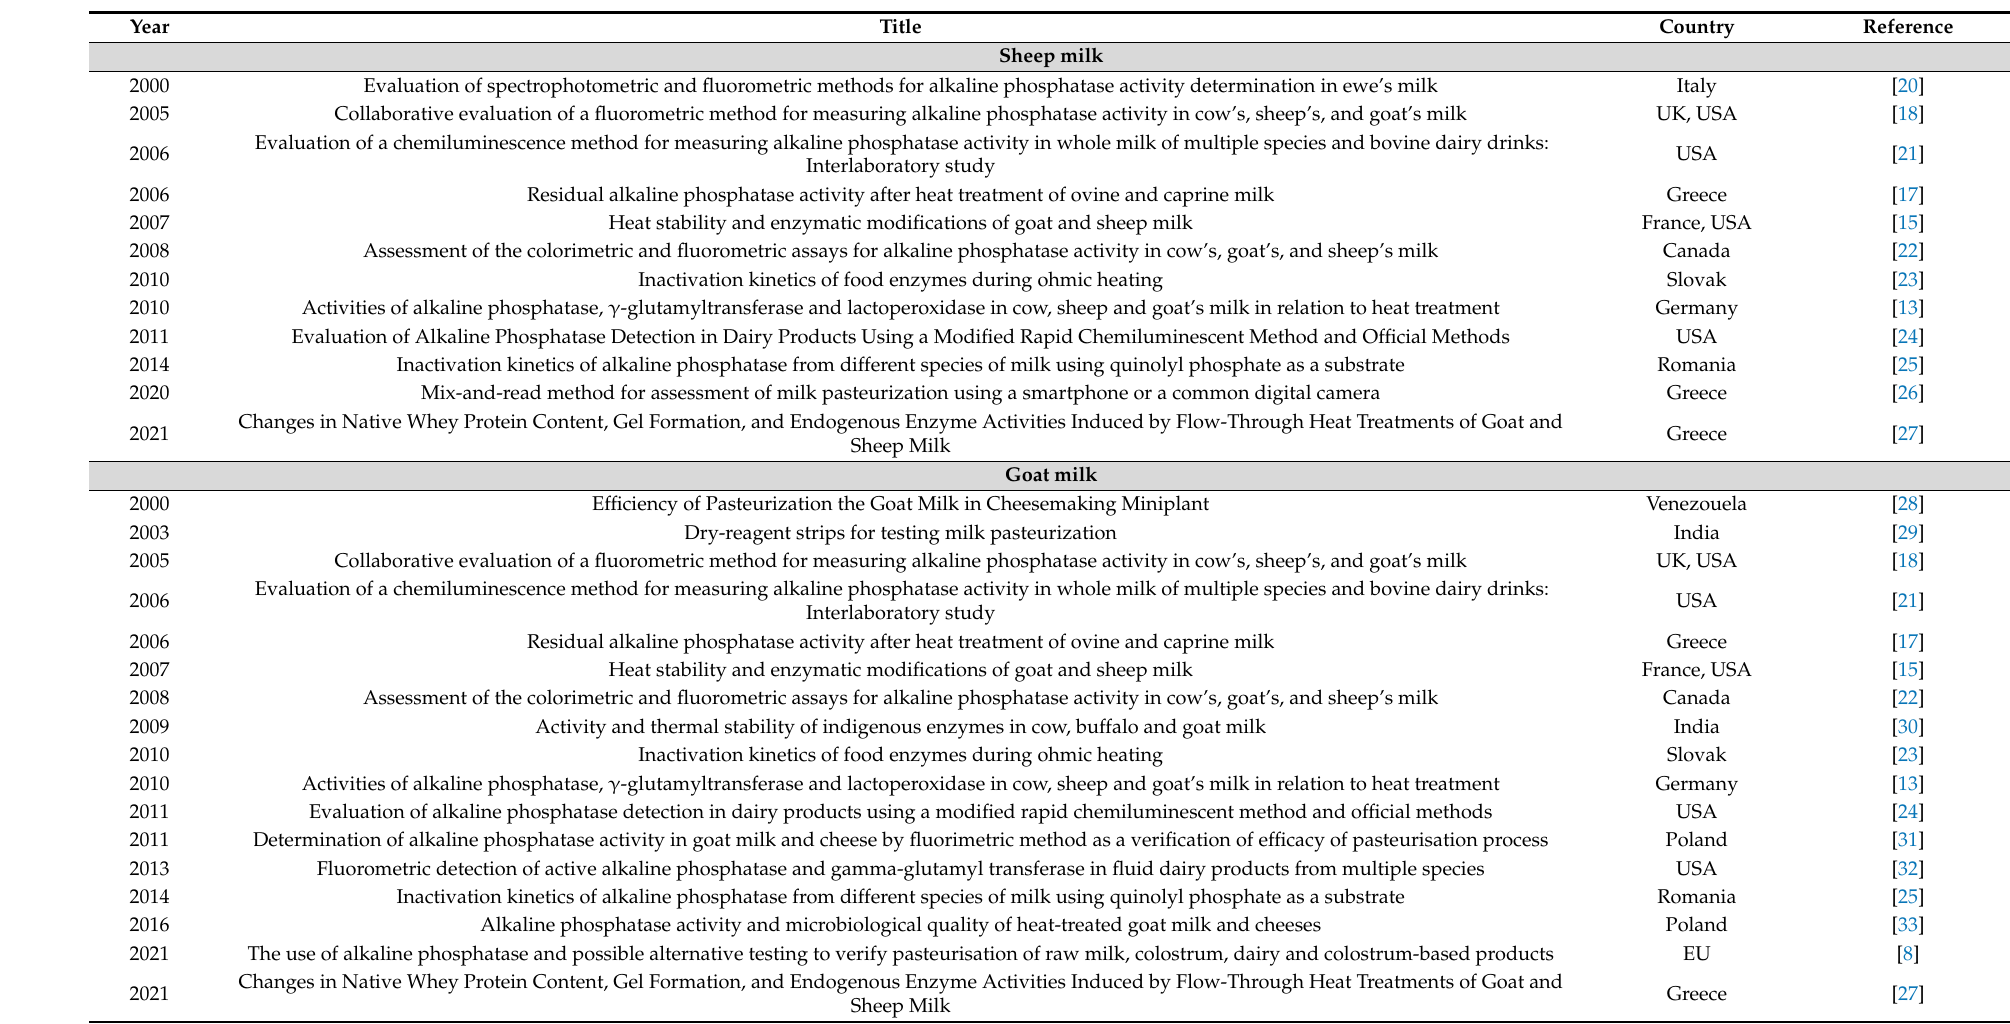
Table 1. List of selected references on the activity of ALP in different types of milk and dairy